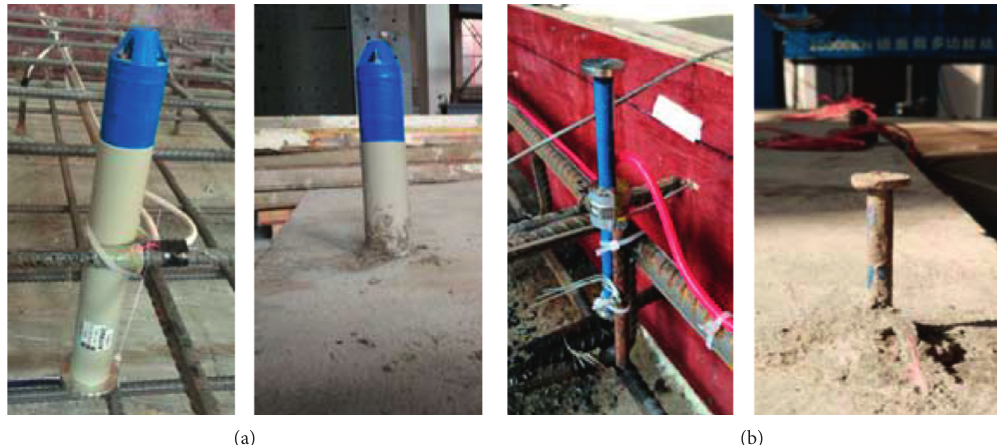
Figure 13: Layout of the measuring sensors. (a) Layout of embedment joint meters. (b) Layout of strain gauges.